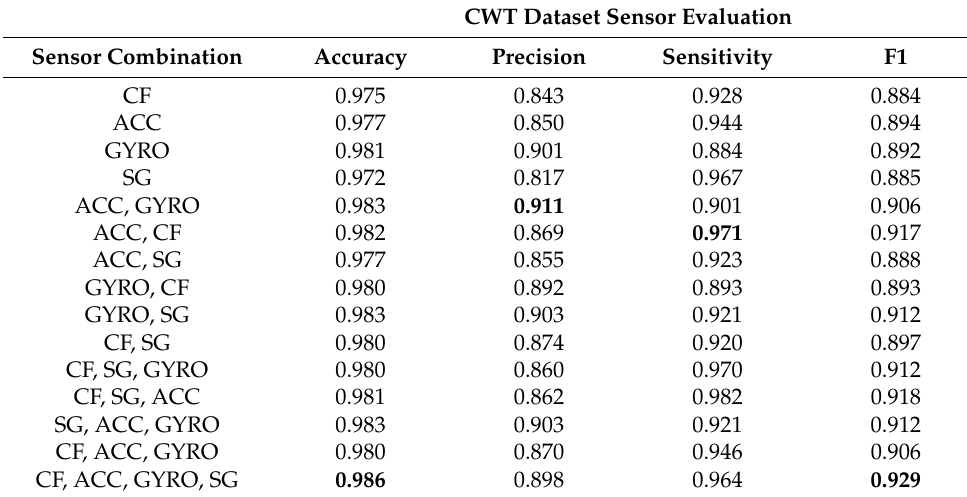
Table 11. Sensor importance evaluation for FOG